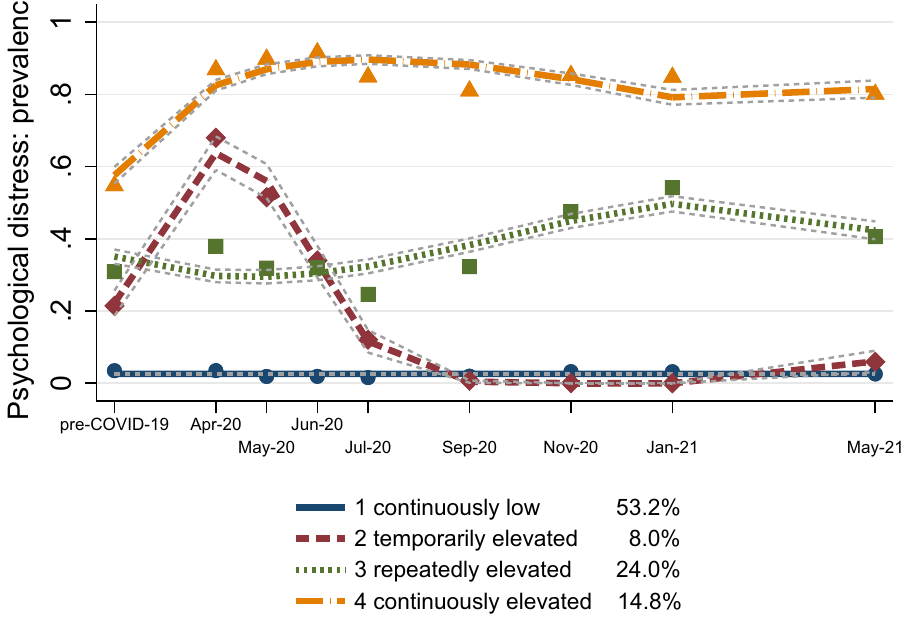
Figure 1. Four latent trajectories of psychological distress. Error bounds represent 95% confidence intervals. Based on Understanding Society COVID-19 Study ( N = 15,914 ).